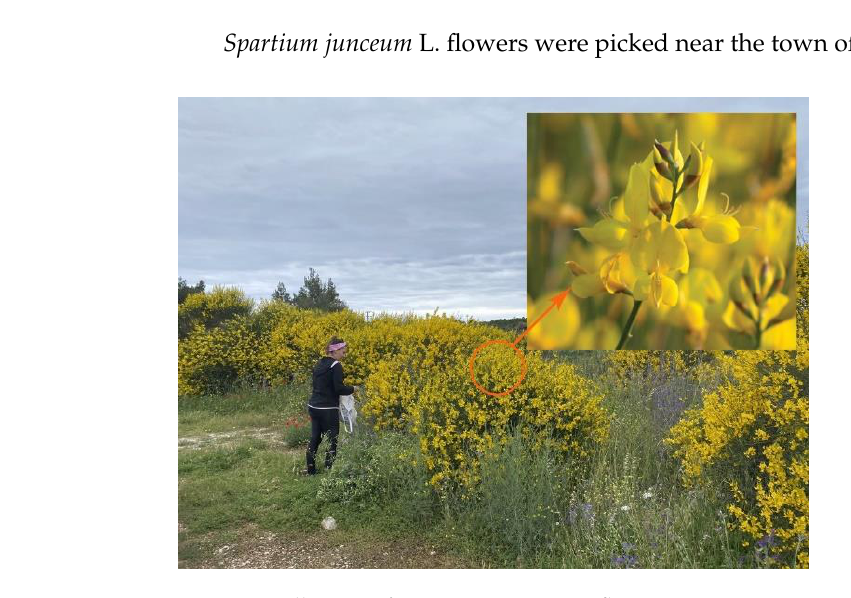
Figure 1. Collecting of Spartium junceum L. flowers in May 2021.